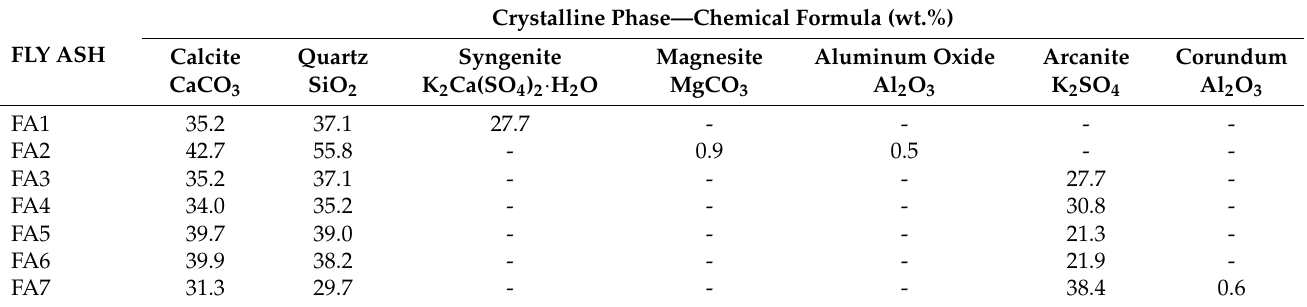
Table 4. Laser beam particle size analysis of fly ashes (Volume, Number, Surface,